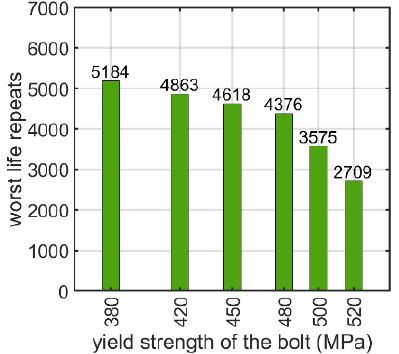
Figure 12. Number of logarithmic life repeats for prestressing force parametrization of the bolt with a nut connection. 3.1.4. Fatigue Analysis Algorithm The last factor analyzed was the fatigue algorithm. Four fatigue hypotheses were adopted here: the maximum shear strain criterion (MSS), the Brown–Miller–Morrow cri- terion (BMM), the Morrow criterion (Morrow), and the Smith–Watson–Topper criterion (SWT), all of which are described in Section 2.2. In Figure 13, the results of the logarithmic life repeats for different fatigue algorithms for the prestressed bolt with a nut are pre- sented. The values presented are the minimal values of the logarithmic life repeats taken for each connection from the fatigue distribution (not shown).